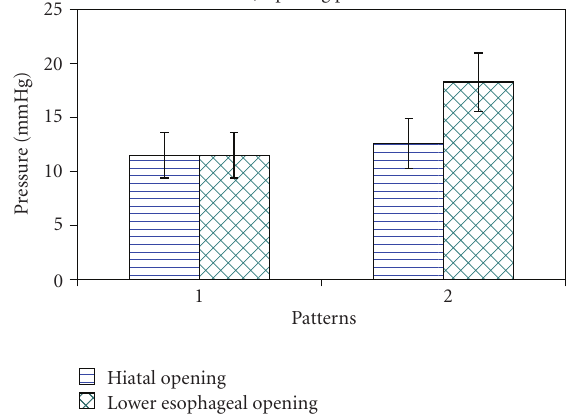
Figure 5: This graph shows the two di ff erent patterns of GEJ opening in normal